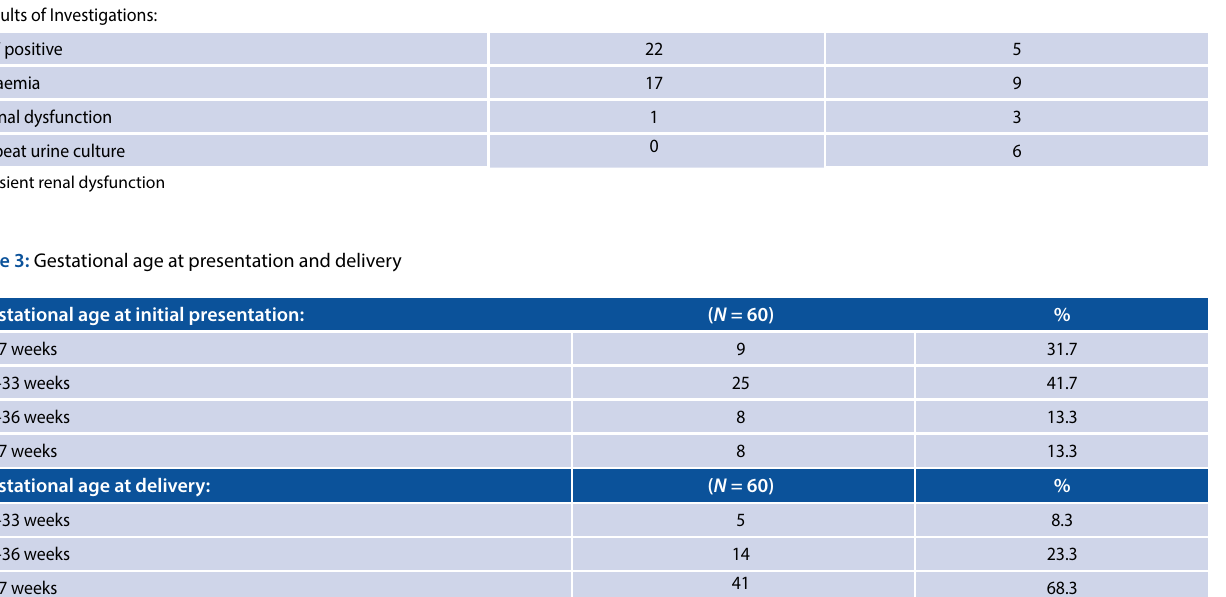
Results of Investigations: